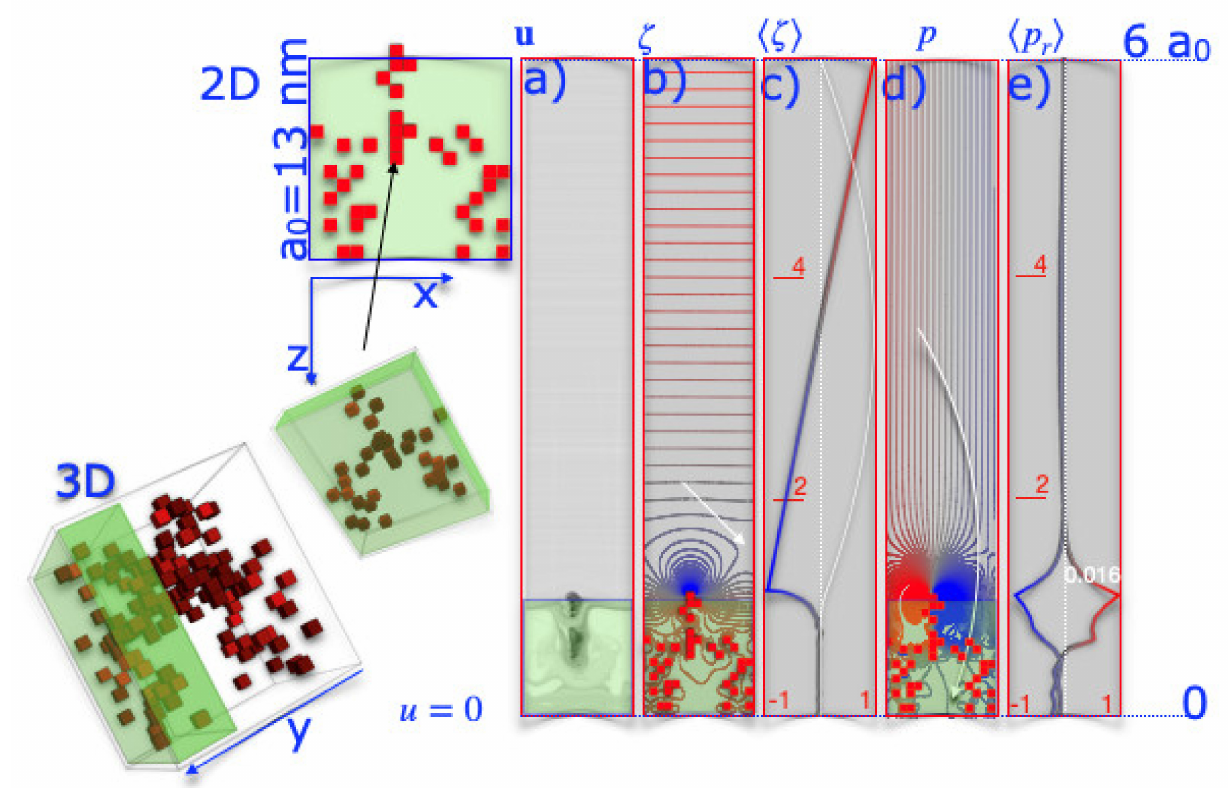
Figure 5. The Navier–Stokes flow profile. The 3D model of SbpA was collapsed to 2D. Red squares mark stiff regions within the S-layer placed at the bottom of a 1 by 6 a 0 simulation box, a 0 =13 nm. Velocities were kept zero at z = 0 and z = 6 a 0 . Periodic boundary conditions were imposed in the x-direction. ( a – e ) The results of the Navier–Stokes equation are summarized. ( a ) Line integrals represent the velocity field u ; ( b ) blue and red lines mark low and high vorticity, ζ ; ( c ) the color-coded line gives the average vorticity (cid:104) ζ (cid:105) over a unit cell; and ( d ) the pressure, p , and ( e ) the average pressure, (cid:104) p r (cid:105) , are